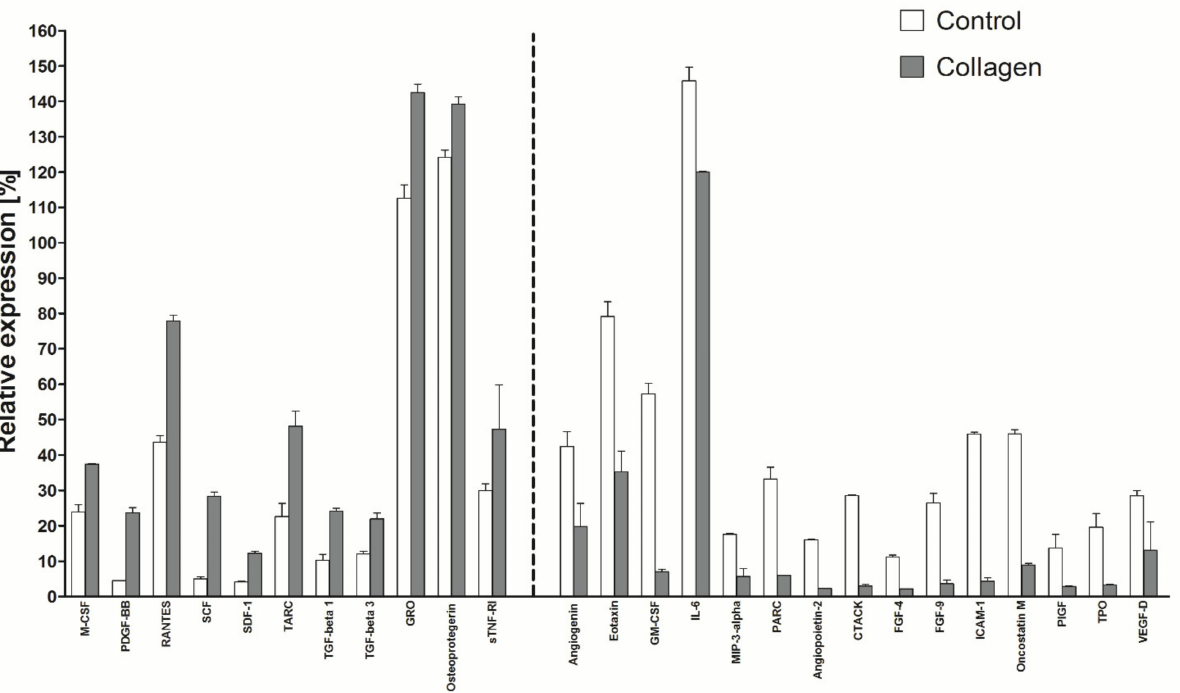
Figure 7. Selected cytokine production as a function of culture on collagen discs and extended culture time. The secretory profile of the tested line was determined using the RayBio C-series Human Cytokine Antibody Array for a panel of 120 cytokines and expressed as a histogram relative to a positive control. The data represent the mean from a duplicate assessment